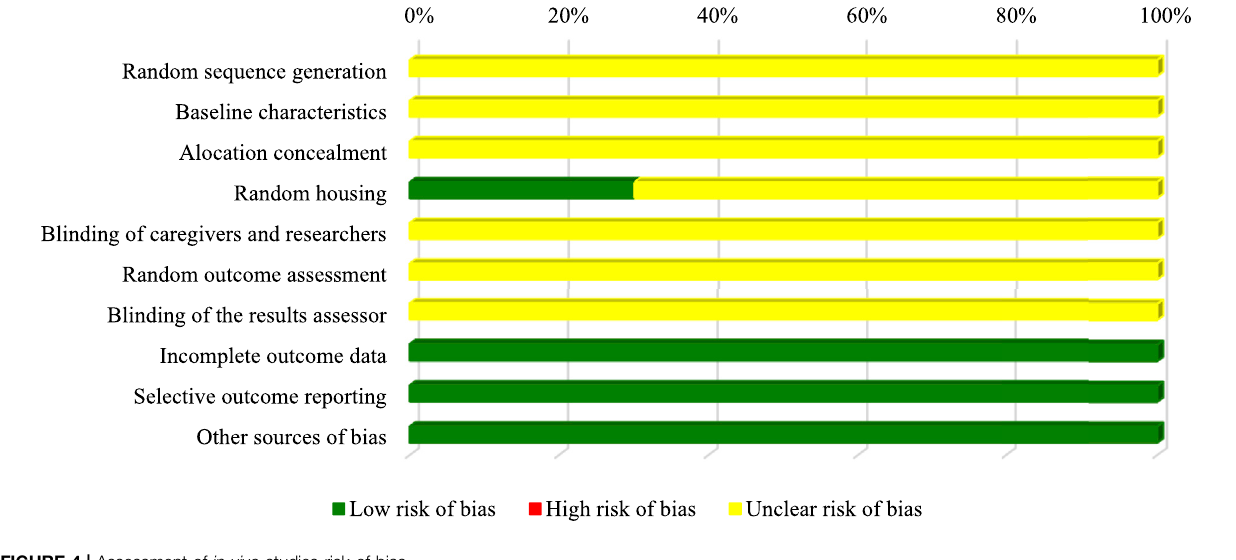
FIGURE 4 | Assessment of in vivo studies risk of